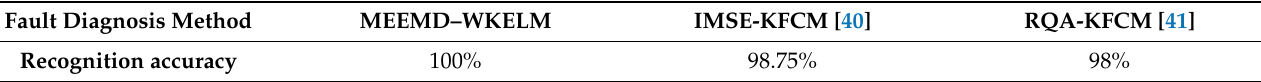
Table 8. Comparison of diagnostic accuracy of fault diagnosis